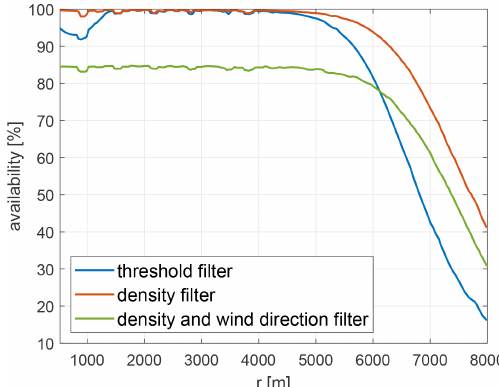
Figure 7. Data availability dependent on range gate when apply- ing the threshold filter (blue) and the density filter (red). In green the availability after applying the density filter and neglecting the critical angles and wind speed outliers is